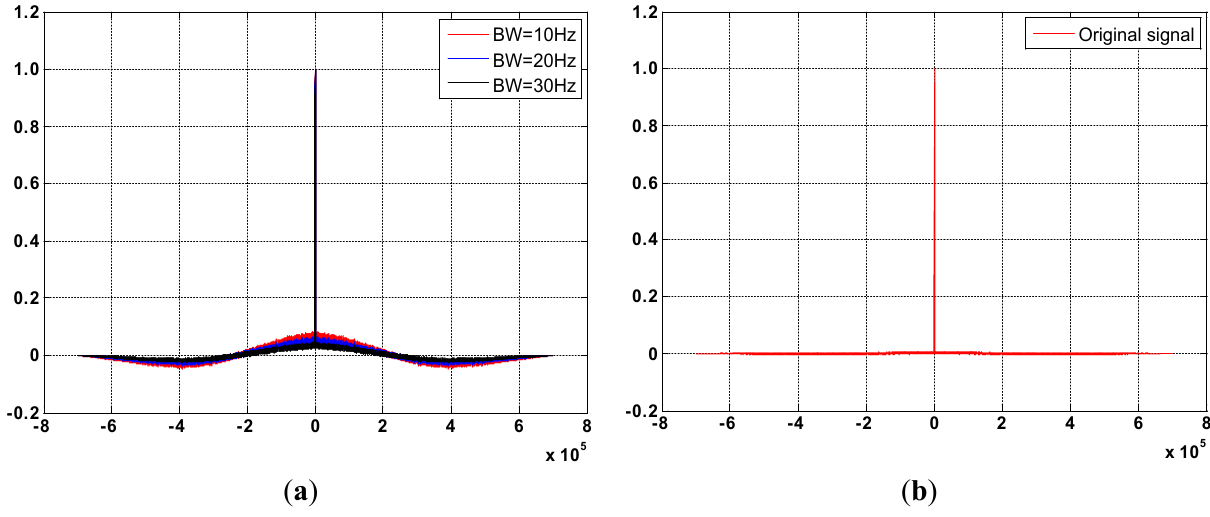
Figure 6. Auto-correlation functions of the filtered rate signal and original rate signal under different KF bandwidths. ( a ) Filtered rate signal. ( b ) Original rate